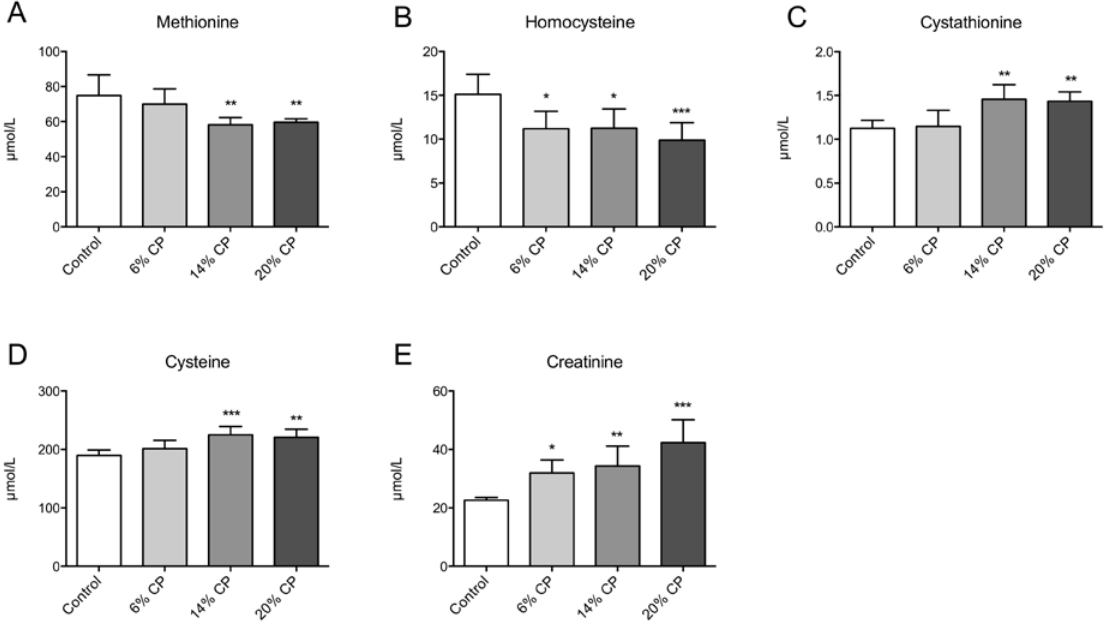
Figure 2. Plasma concentration of metabolites related to homocysteine metabolism. Rats were fed a 20% (w/w) casein control diet, or a diet containing 6%, 14% or 20% chicken protein (CP) for 4 weeks. Methionine ( A ), homocysteine ( B ), cysteine ( C ), cystathionine ( D ), and creatinine ( E ), were measured in fasting plasma samples. Values shown are